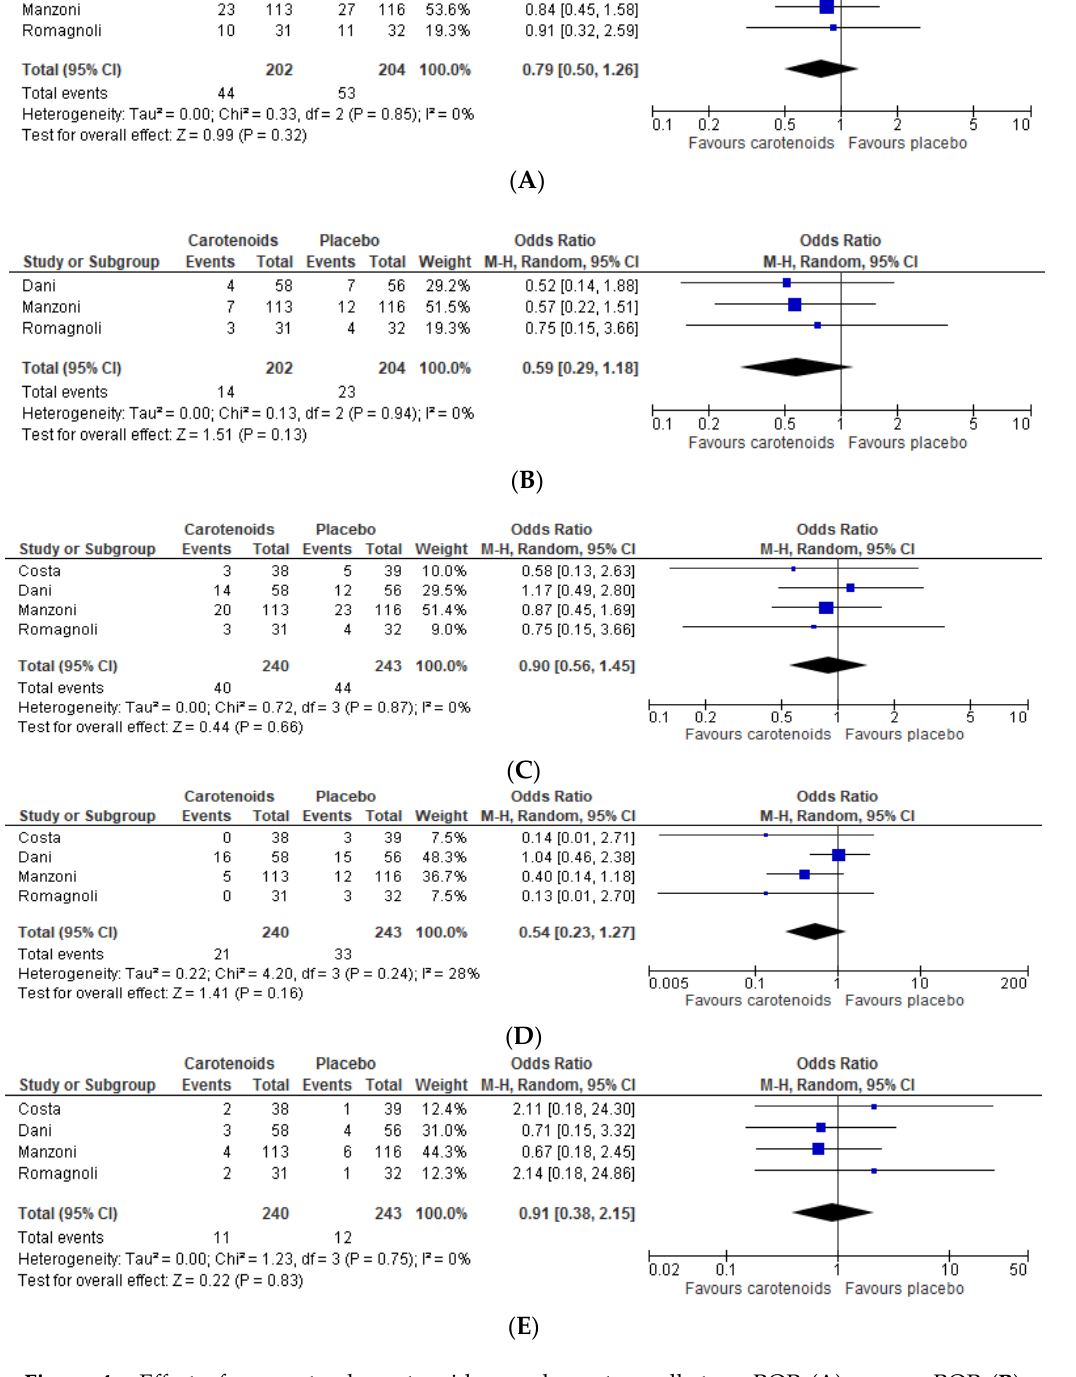
Figure 4. Effect of any enteral carotenoids supplement on all-stage ROP ( A ), severe ROP ( B ), culture-proven late-onset sepsis ( C ), BPD ( D ), and mortality ( E ) in preterm infants. ROP: retinopathy of